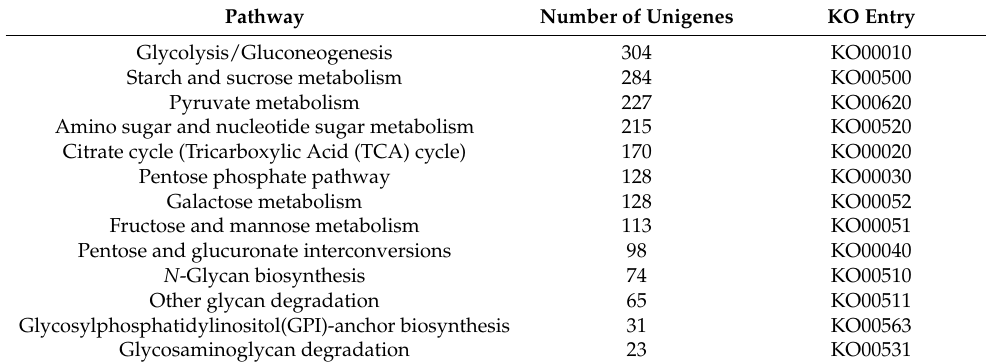
Table 5. Thenumberofunigenesinvolvedinpolysaccharidebiosynthesisin Polygonatum sibiricum database.